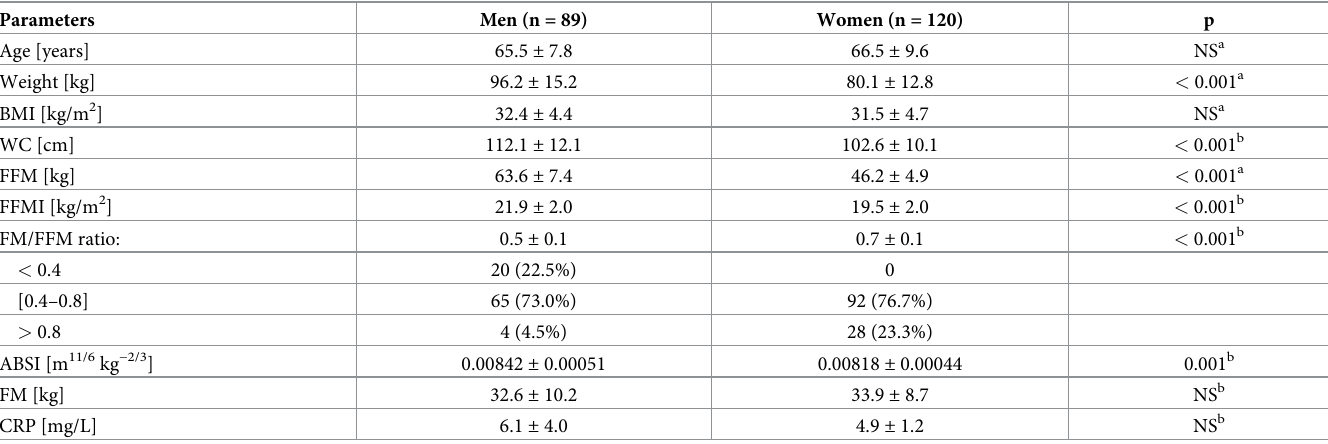
Table 1. Baseline characteristics of the patients.